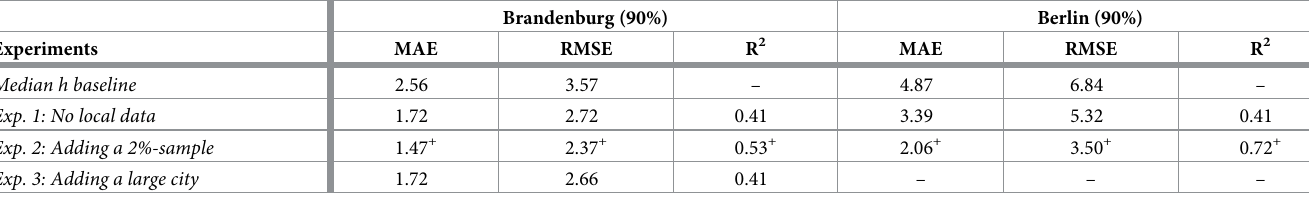
Table 4. Results of the experiments of the test